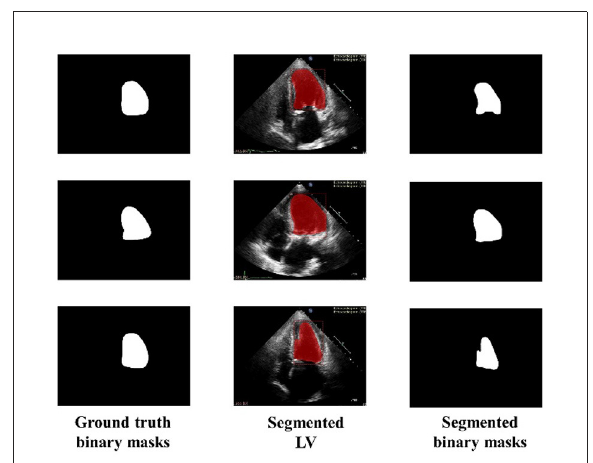
The SegNet results in the lowest average DSC level (0.7651),